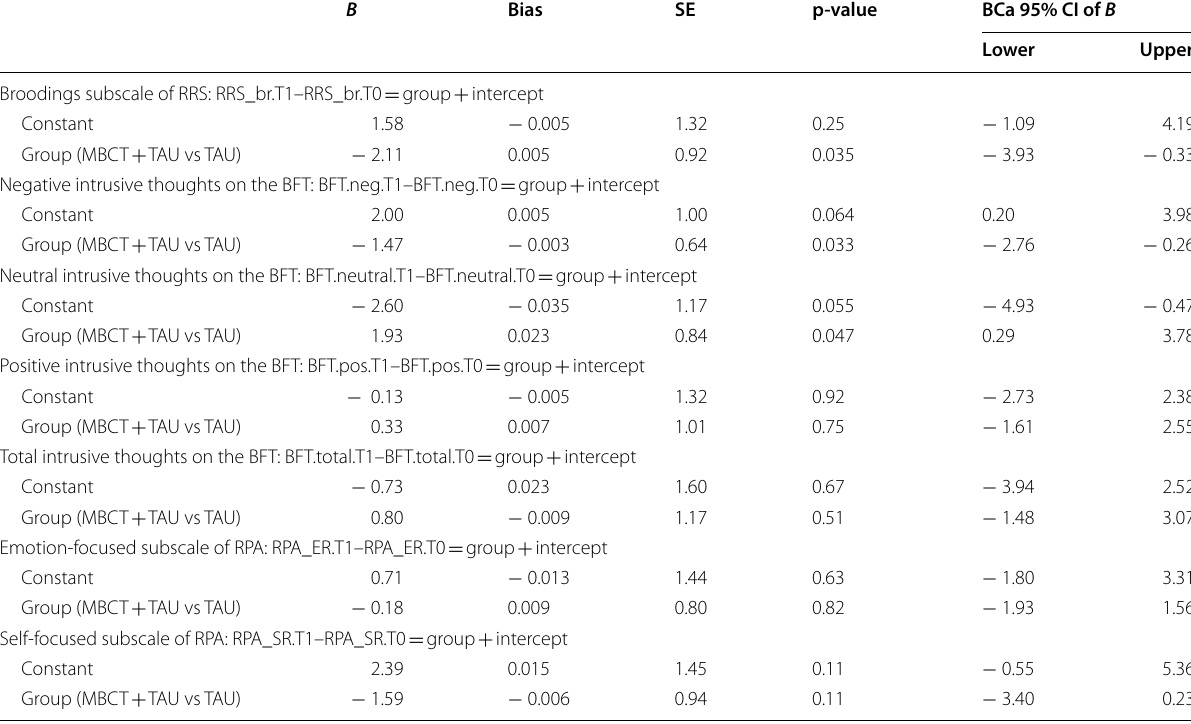
Table 2 Bootstrapped Bias‑corrected and Accelerated 95% confidence intervals of B for regression equations regarding change scores of depressive rumination, intrusive thoughts on the breathing focus task and positive